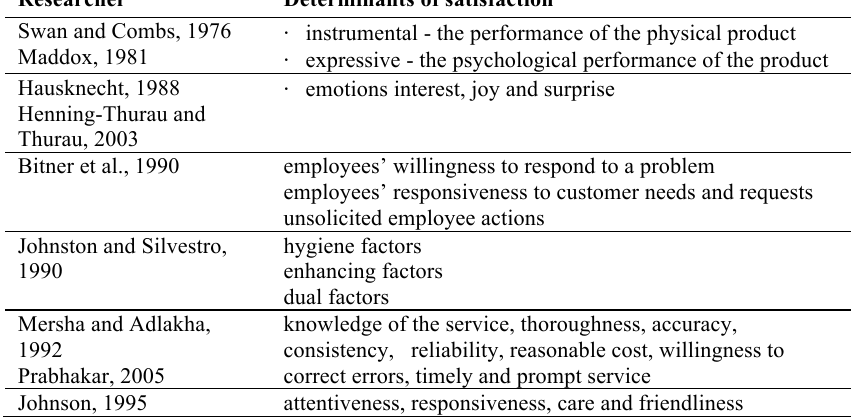
Table 1. Customers’ satisfaction determinants in selected surveys (Klimontowicz, 2014) Researcher